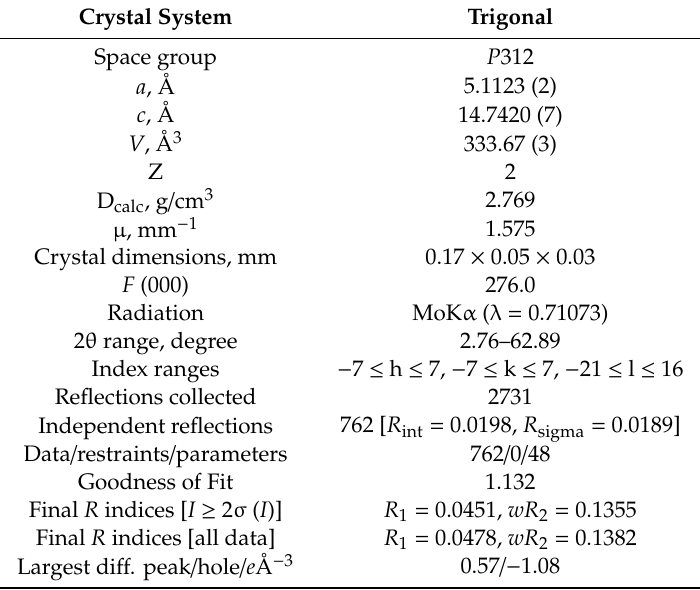
Table 1. Crystal data and structure refinement for dmisteinbergite.